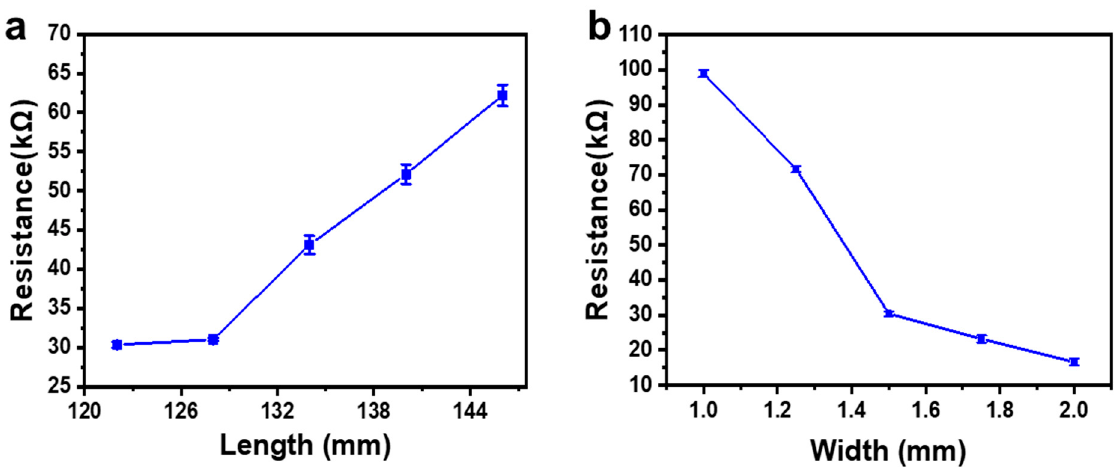
Figure 6 . Change in resistance with ( a ) the length and ( b ) the width of the wires in the serpentine structure. Figure 7. Optical image of the experimental setup for bending strain test.